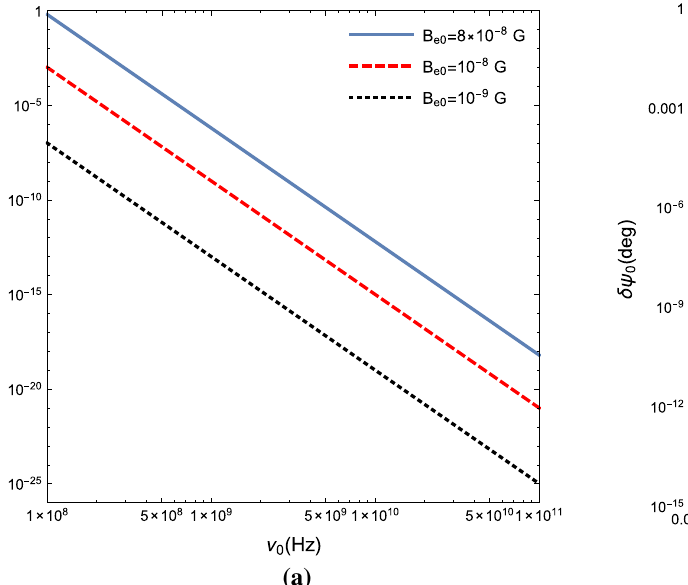
( a ) (b) δψ | r | ∈ [ 10 − 3 , 10 ] for some Fig. 8 a Logarithmic scale plots of the rotation angle of the CMB 0 (in degrees) given in (74) as a function polarization plane at present δψ 0 (the absolute value in degrees) due specific values of the magnetic field amplitudes B e 0 and frequencies ν 0 to the CM effect given in (74) as a function of the CMB frequency for (cid:16) = 0 are shown. In both a and b we have chosen those values of ν ∈ [ 10 8 , 10 11 ] (Hz) for some specific values of the magnetic field the parameters that satisfy the condition | 2 r δψ( T ) | < 1 that is always 0 satisfied at T = T 0 for T 0 ≤ T ≤ T amplitude B e 0 , (cid:16) = 0 and | r | = 1 are shown. b Logarithmic scale plots of the rotation angle of the CMB polarization plane at present